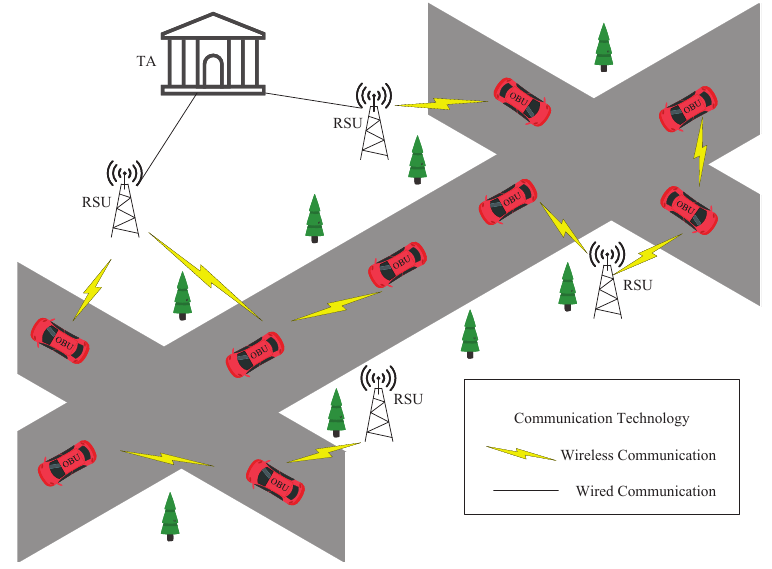
Figure 1. System